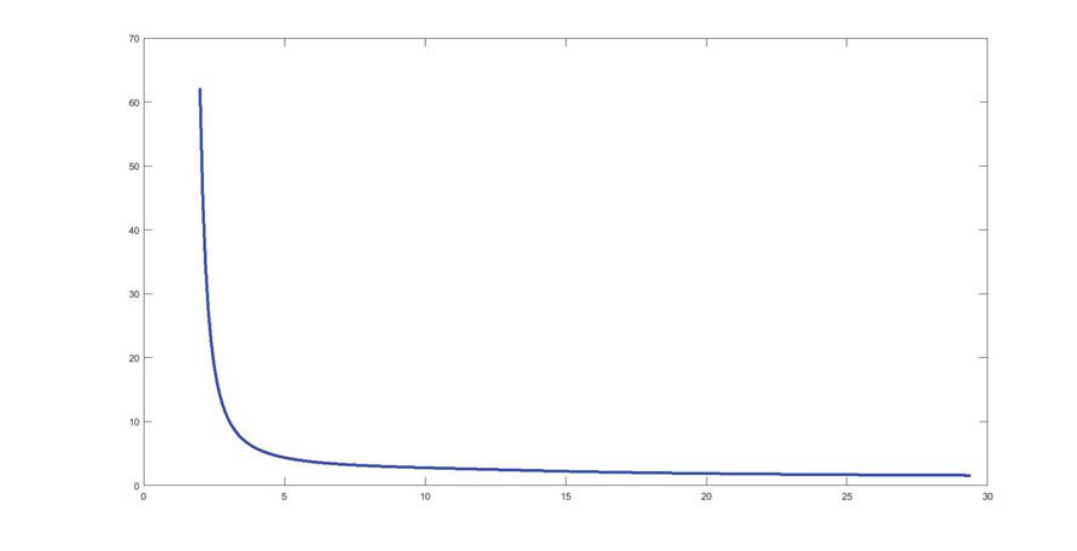
Fig. 18: Function values at the central peaks of the numerical solutions with two nodal regions and 3-symmetry